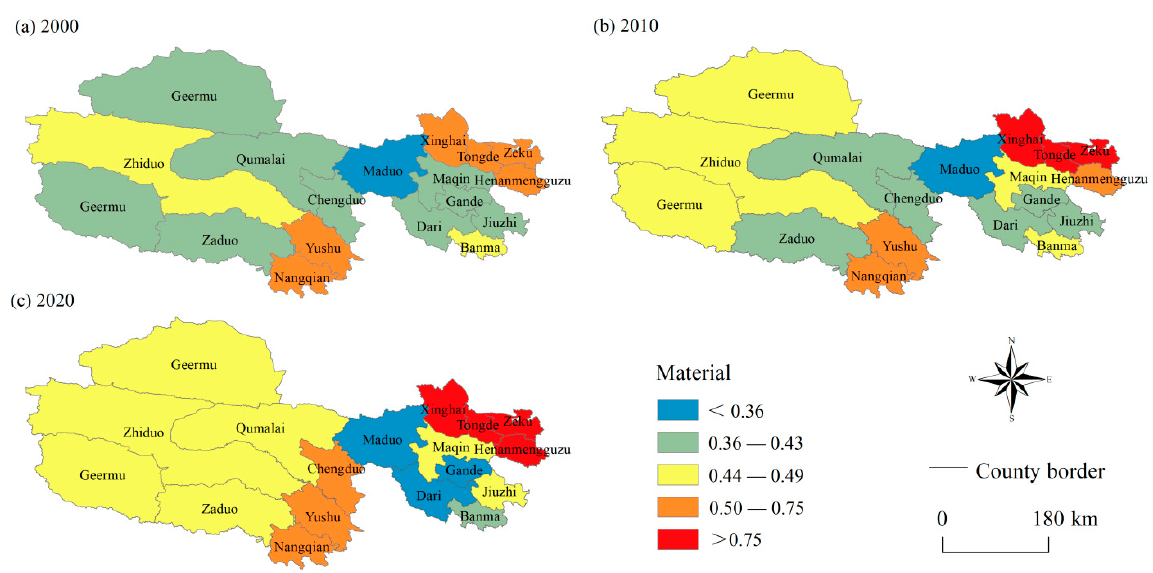
Figure 4. Spatiotemporal differences in the material index (MI) in the Sanjiangyuan area during 2000–2020.